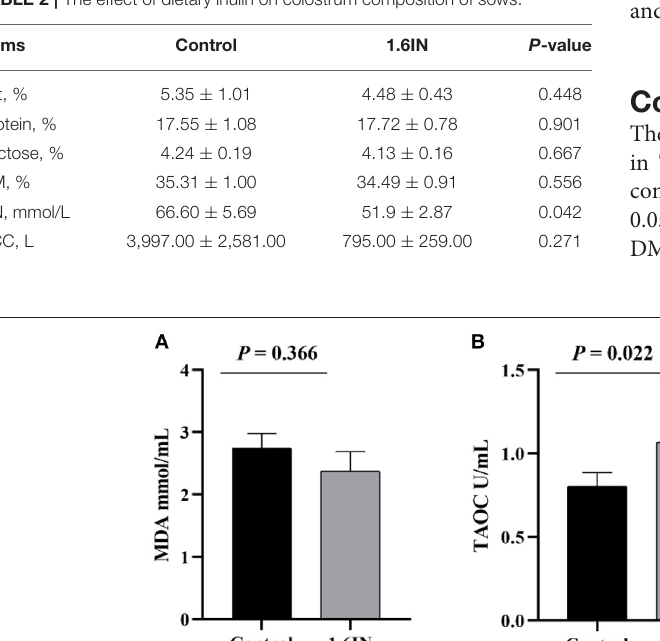
Frontiers in Nutrition |